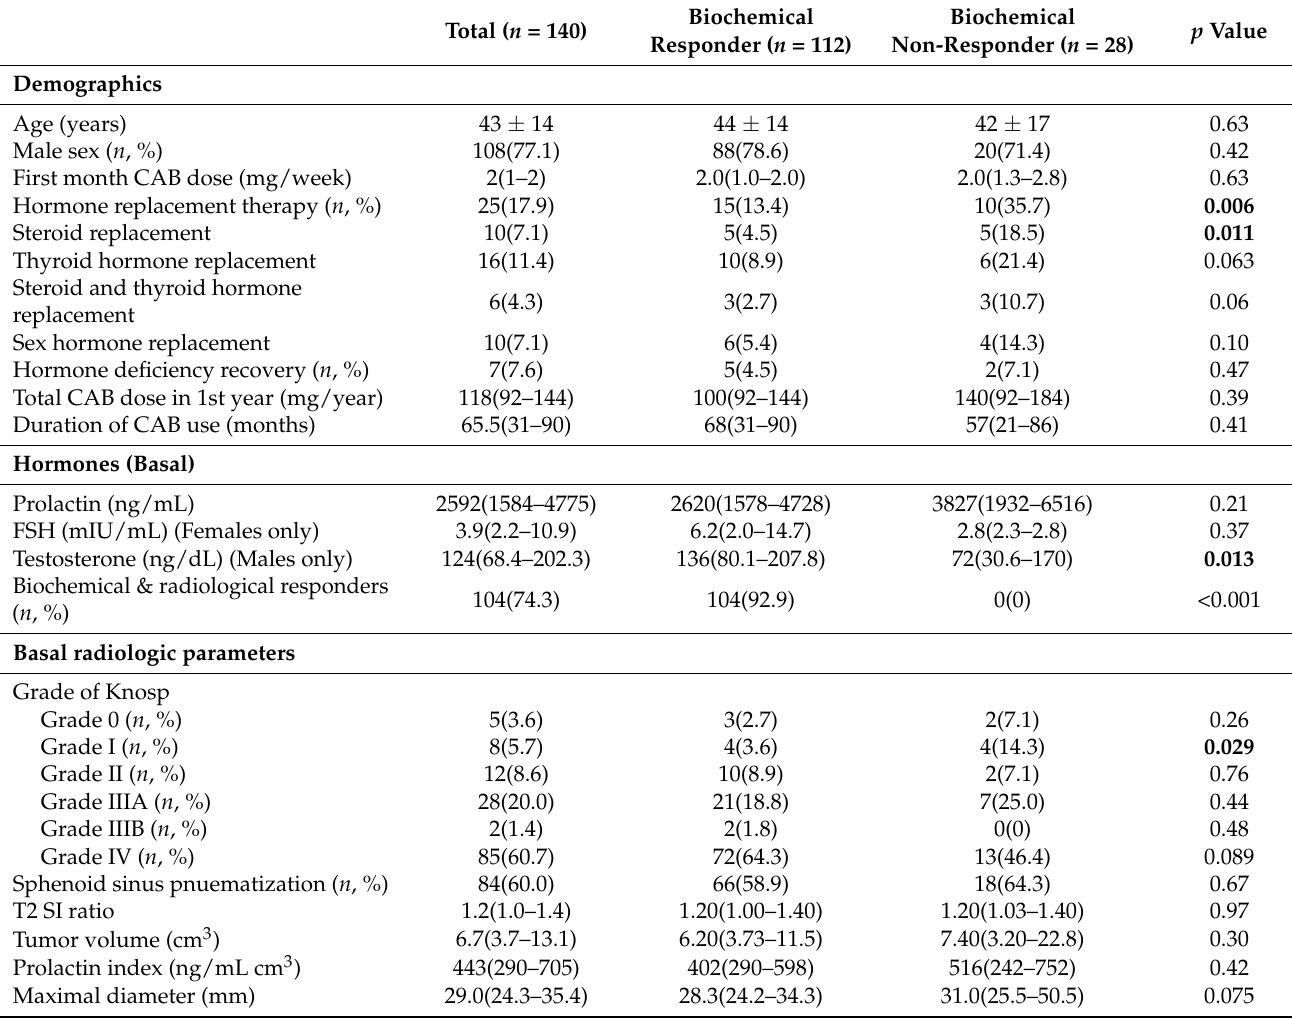
Table 2. Baseline characteristics of bioactive prolactinoma according to hormonal response of